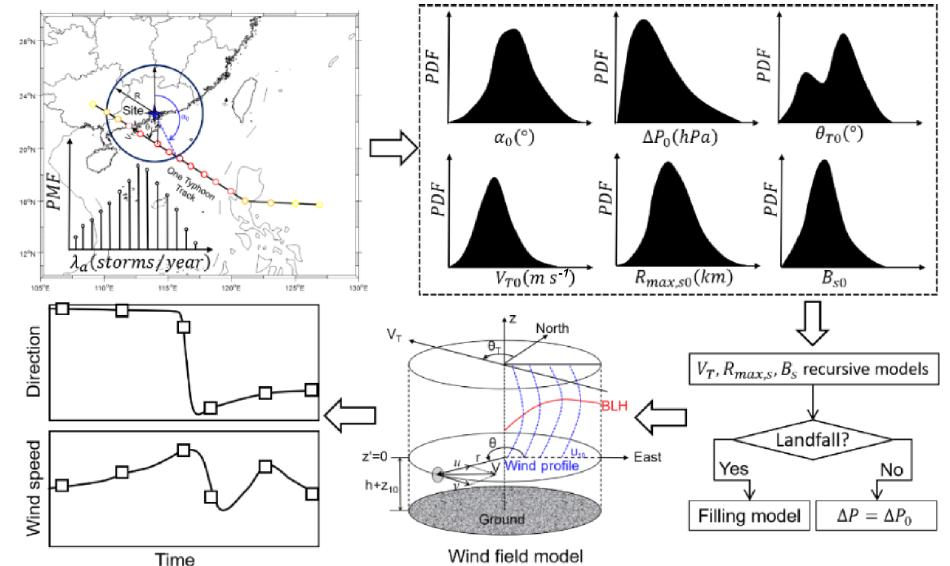
Figure 1. Overview of circular subregion method used in this